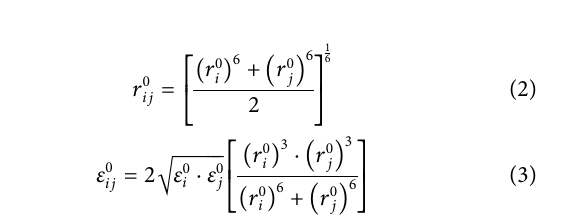
Frontiers in Earth Science |